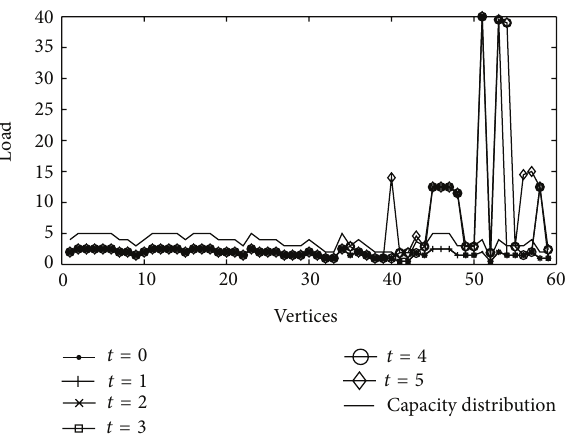
Figure 6: Load distributions of the evolution process in Case I(2).